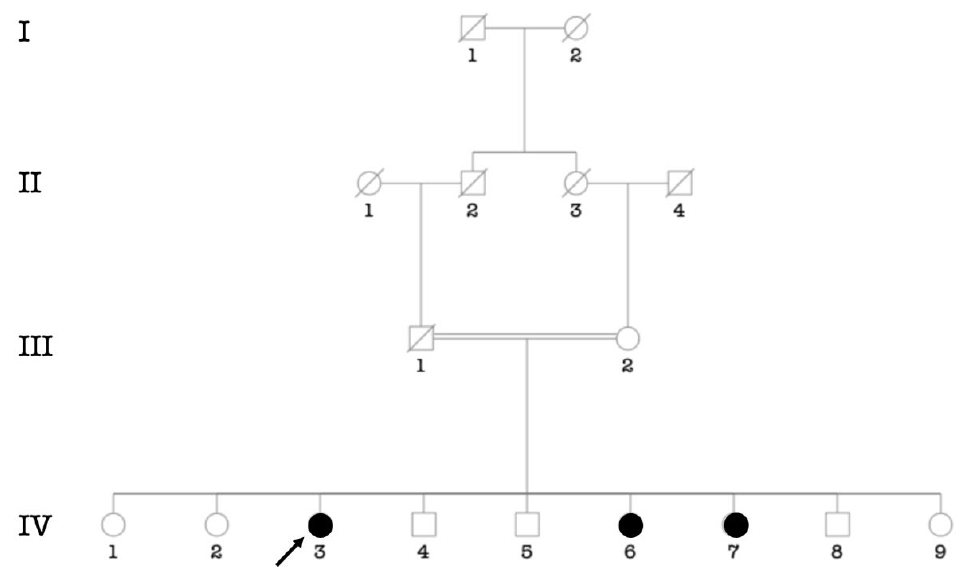
Figure 6. Pedigree of a multiplex family showing three affected girls from a non-consanguineous marriage segregating Diabetes-deafness syndrome. The arrow indicates the proband.